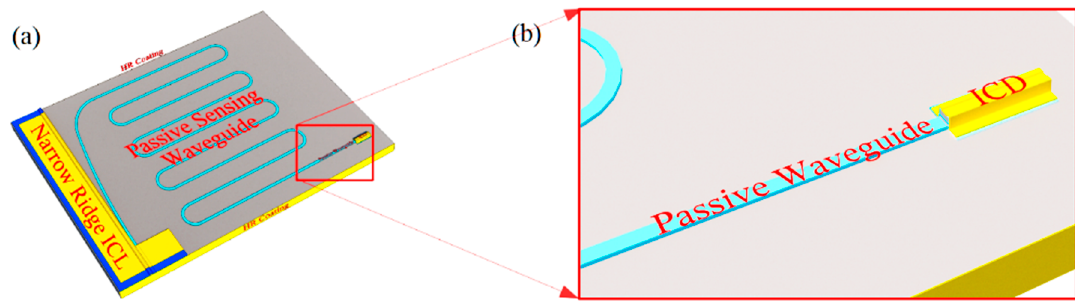
Figure 10. ( a ) Schematic of an ICL with lateral out-coupling, extended passive sensing waveguide, and interband cascade detector integrated on the same III-V chip; ( b ) detail of the passive waveguide leading to the ICD.